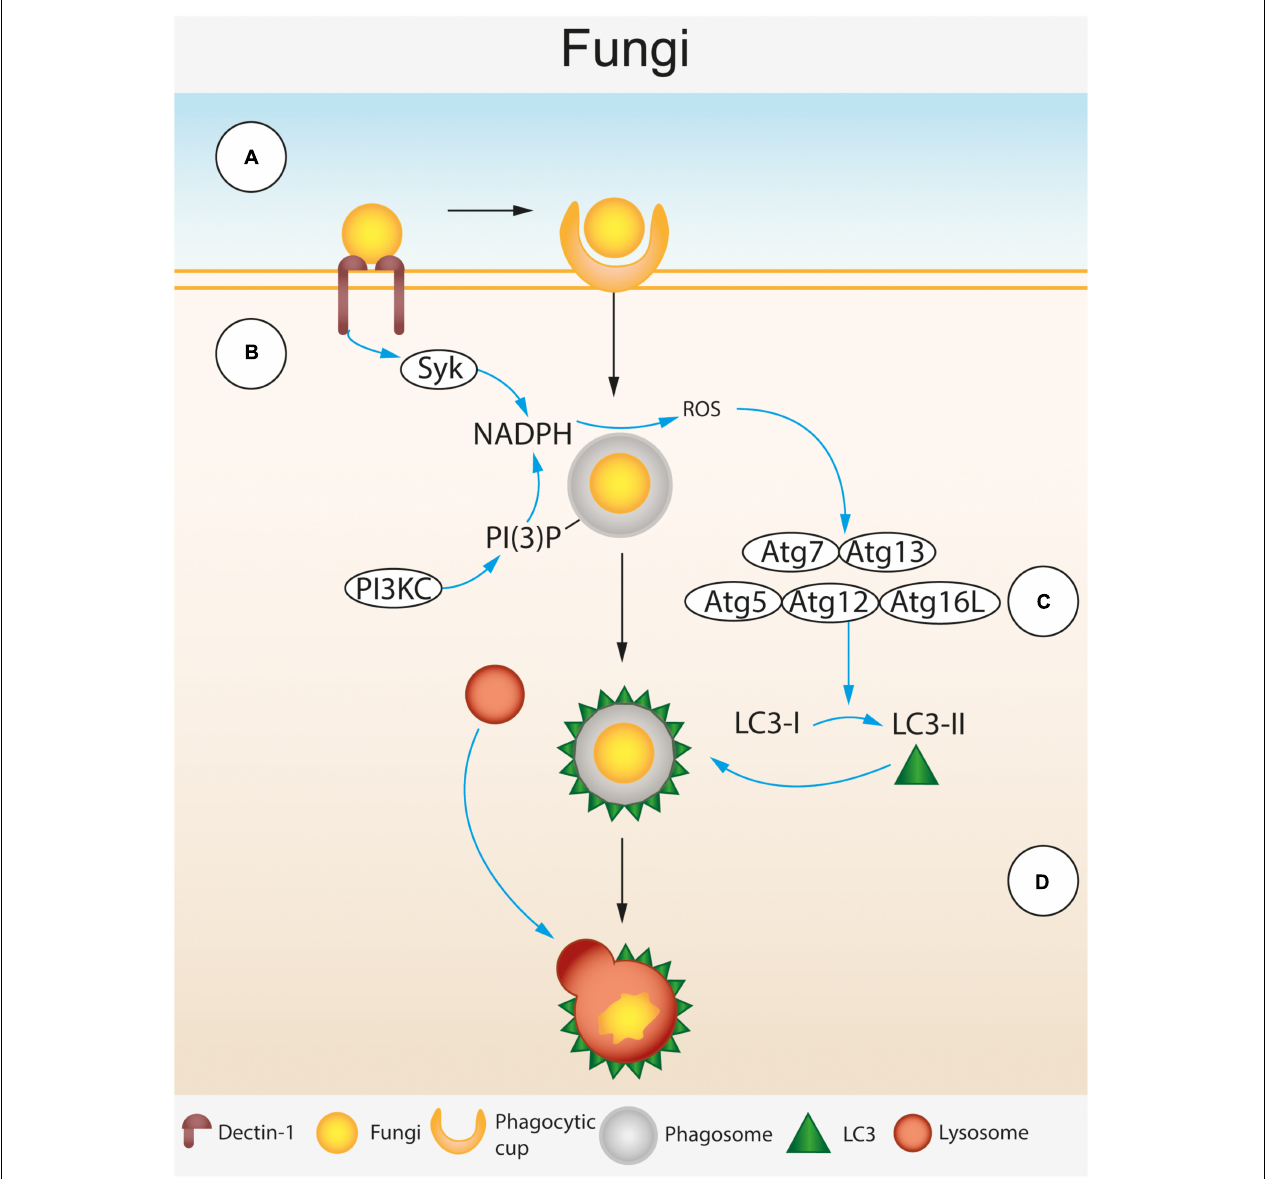
FIGURE 4 | Autophagic control of Fungal spp. LC3-associated phagocytosis (LAP) during fungal infection of macrophages. (A) β 1,3 glucan residues in the fungal cell wall are recognized by the cell surface receptor Dectin-1 expressed on the surface of the macrophage (Brown and Gordon, 2001; Brown et al., 2002; Brown, 2006). Dectin-1 recognition leads to phagocytosis of fungal cells. Following phagocytosis, the phagocytosed fungus is enclosed by a single membraned phagosome within the cytosol. (B) Dectin-1 activation triggers spleen tyrosine kinase (SyK) activation (Gantner et al., 2003). Activated Syk and phosphatidylinositol